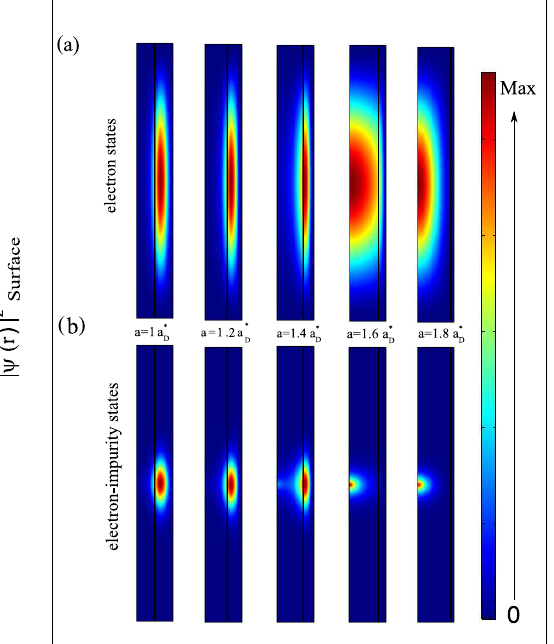
Figure 7. The probability density distribution of the electron inside Al x Ga 1 − x As/GaAs-based core/shell NW with shell radius b = 2 a ∗ and height h = 20 a ∗ , for different values of the core D D radius: from a = 1 a ∗ by 0.2 to 1.8 a ∗ . The square of the wave function describes the ground state D D level of ( a ) single electron and ( b ) electron-donor impurity system. The representation is the ρ z-plane cross-section with 2D axi-symmetric